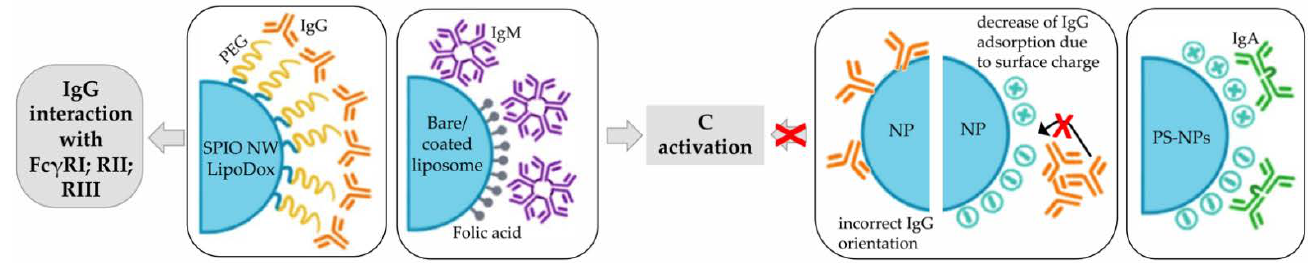
Figure 5. Schematic representation of the role of Igs when adsorbed on NPs. FcR: Fc receptor; SPIO NW: superparamagnetic iron oxide nanoworms; Ig: immunoglobulin; C: complement; NP: nanoparticle; PS: polystyrene.